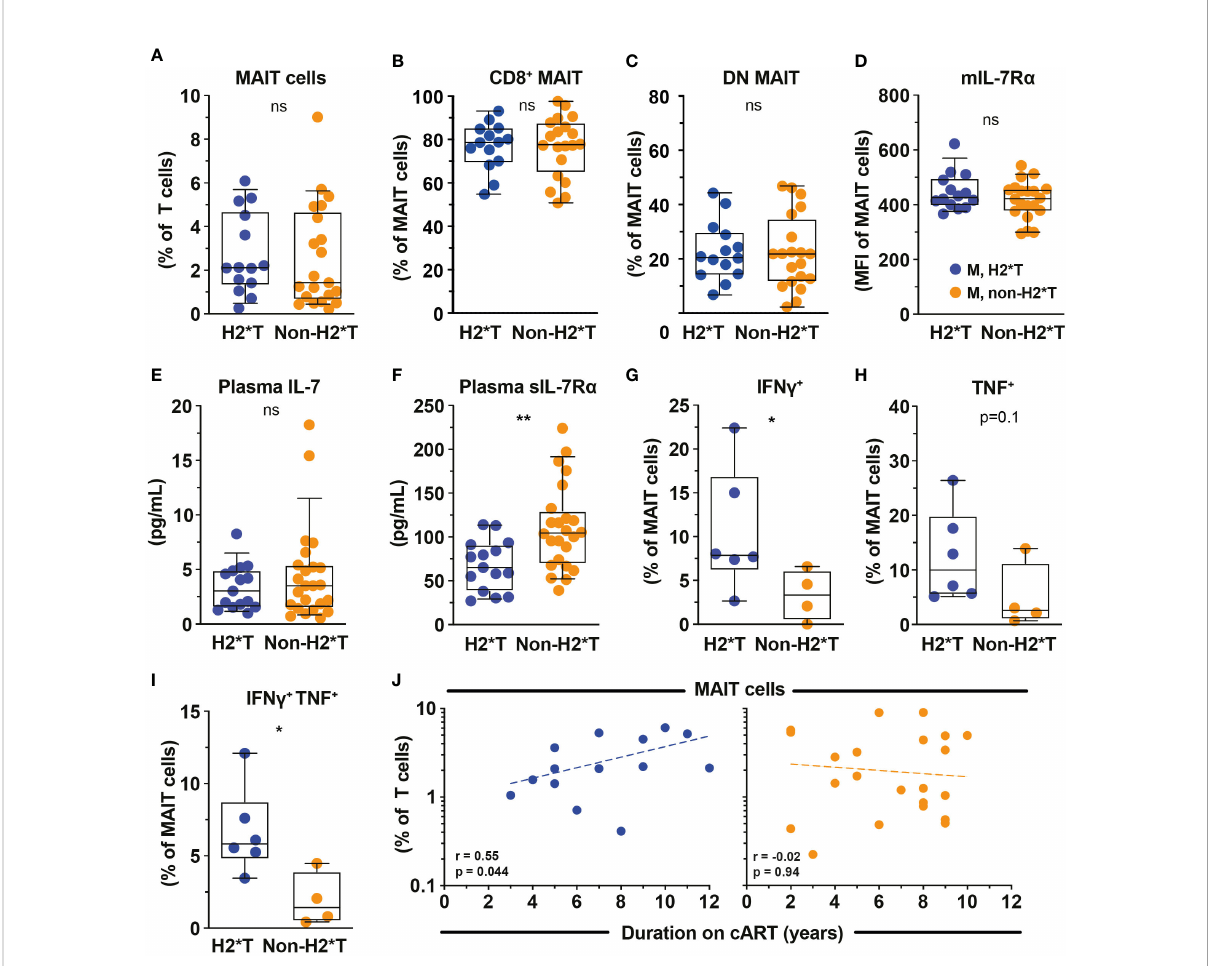
FIGURE 4 MAIT cell levels and functions in HIV-1-infected individuals with long-term viral suppression and their relationship with the IL-7R a SNP. V a 7.2 + CD161 hi MAIT cell levels (A) , the distribution of CD8 + (B) and CD4 - CD8 - (DN; C) MAIT cell subsets, and membrane-bound (m)IL-7R a (D) by MAIT cells in HIV-1-infected individuals bearing the different IL7RA haplotypes. (E, F) Plasma levels of IL-7 (E) and soluble (s)IL-7R a (F) in HIV-1- infected individuals bearing the different IL-7RA haplotypes. (G – I) The IFN g (G) , TNF (H) , and dual IFN g -TNF (I) production by MAIT cells following 24 h stimulation with formaldehyde- fi xed E coli (bacterial dose 1 CFU/cell). (J) Spearman ’ s correlation between circulating MAIT cell levels and duration of cART in individuals bearing haplotype 2 (N=14) and non-haplotype 2 (N=22). Box and whisker plots show all data points ( A – E : N=14-15 for haplotype 2 and N=20-24 for non-haplotype 2; G – I : N=6 for haplotype 2 and N=4 for non-haplotype 2), median, and the interquartile range. Statistical signi fi cance was determined using Mann-Whitney ’ s test. ** p<0.01,* p<0.05. ns, not signi fi cant. M, male; H2*T, IL7RA haplotype 2. HIV-1-infected dataset were retrieved from HIV-1-infected cohort depicted in Figure